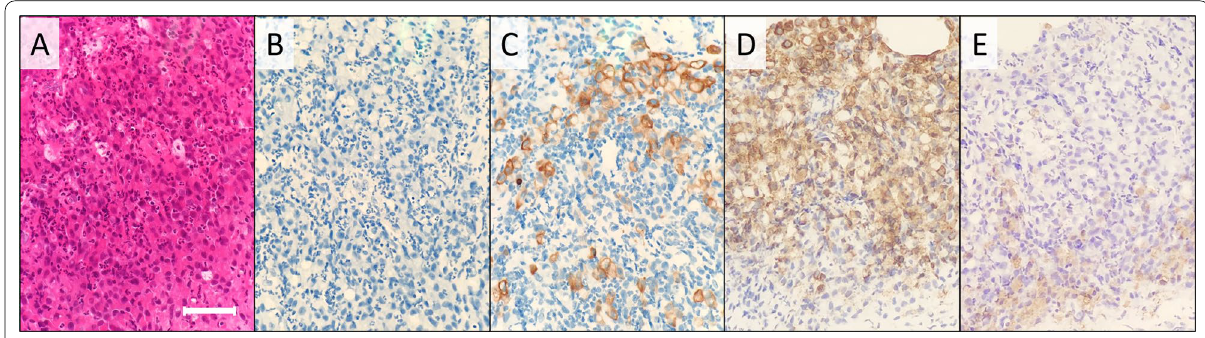
Fig. 5 Pathological findings of needle biopsy. Incoherent atypical cells formed alveolar lesions with marked inflammation ( a , hematoxylin and eosin staining, 200). Tumor cells were negative for CK7 ( b ) and positive for CK20 ( c ), MUC5AC ( d ) and M-GGMC-1 ( e ). A horizontal bar indicates 100 μm ×